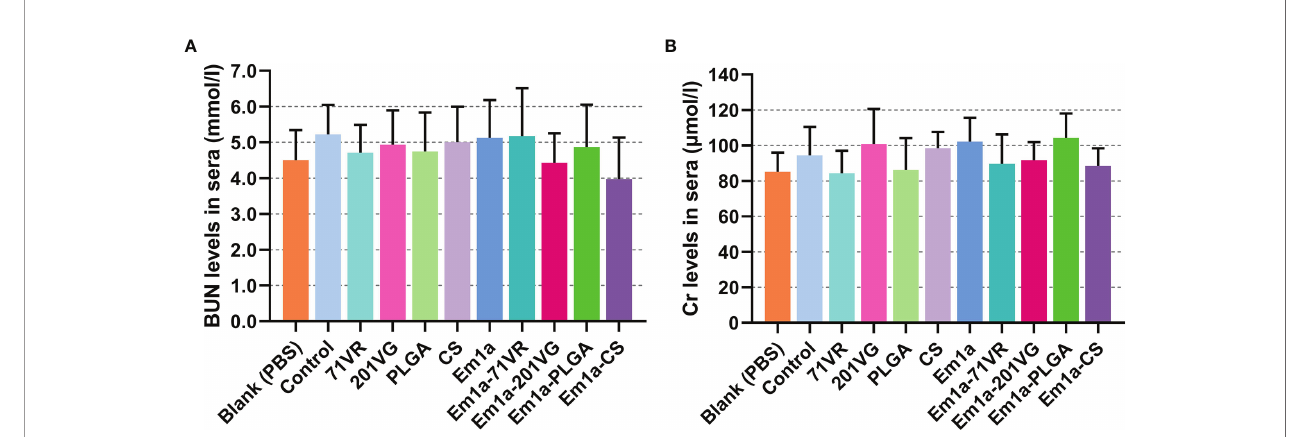
FIGURE 5 | The toxicity of recombinant Em1a proteins and its nanospheres. Based on the urease-indophenol and sarcosine oxidase method, the levels of BUN (A) and Cr (B) were investigated based on the commercial kits. Each sample was tested once, and values were estimated using one-way ANOVA followed by Dunnett ’ s test. Comparisons among Em1a, Em1a-71VR, Em1a-201VG, Em1a-PLGA, and Em1a-CS group were conducted by ANOVA following Bonferroni ’ s correction. Values were presented as the mean ± SD (n =